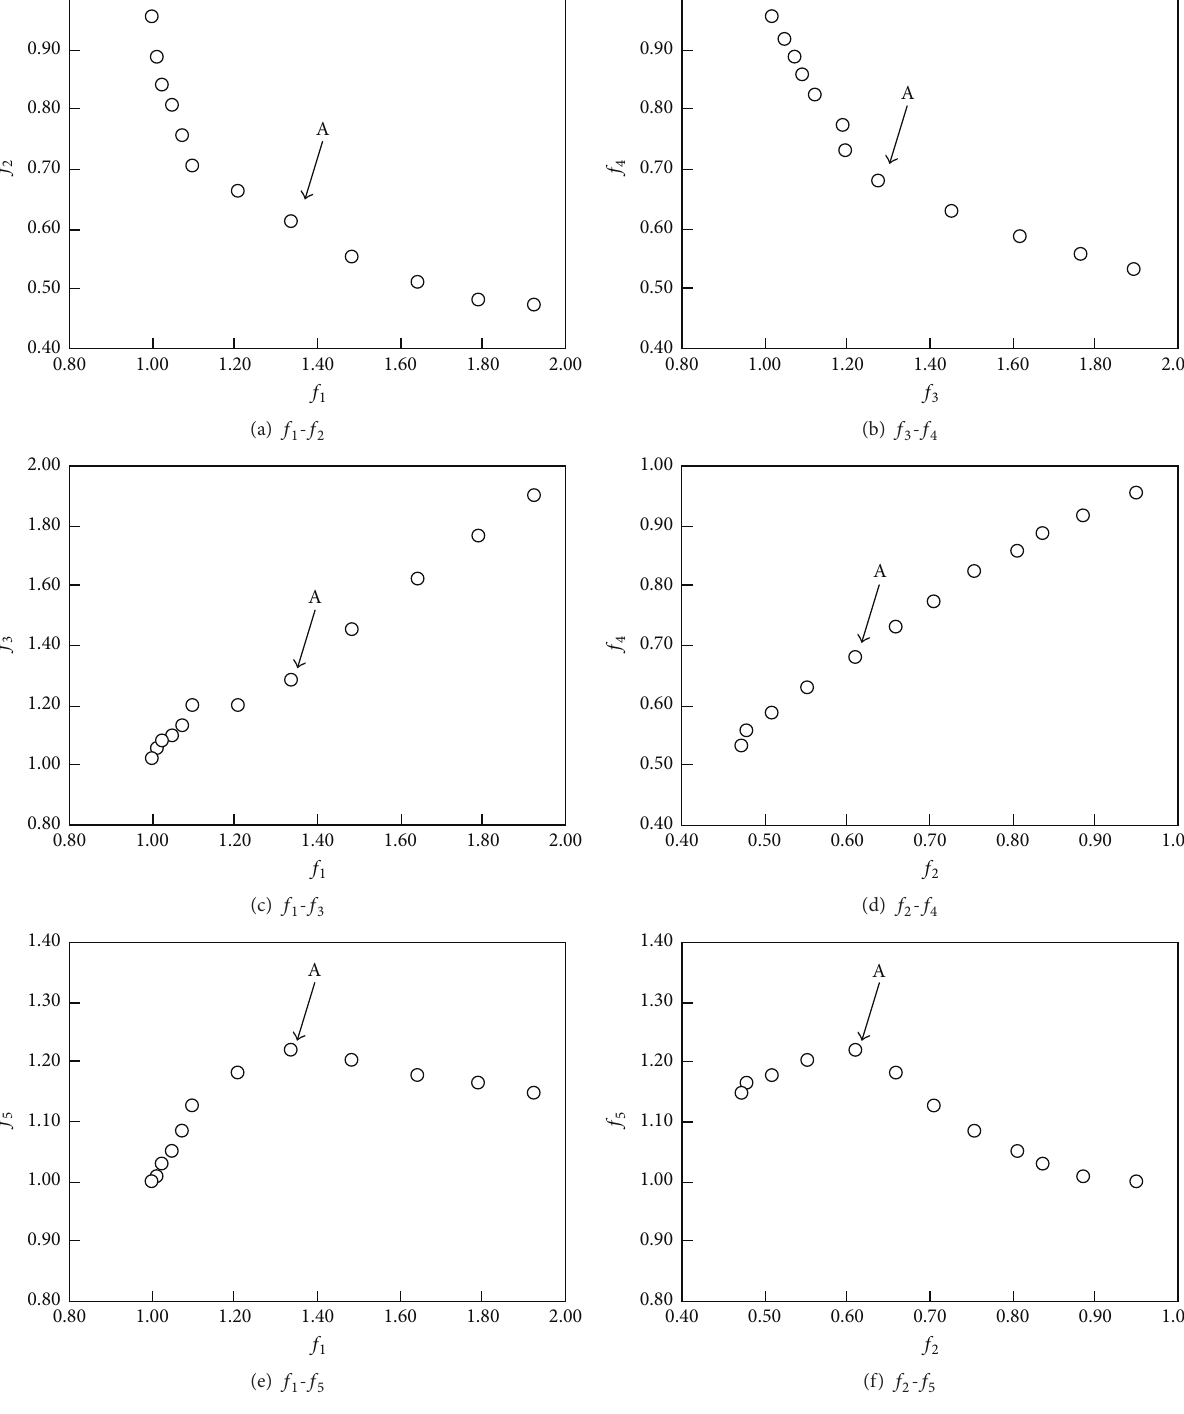
Figure 14: Pareto optimal